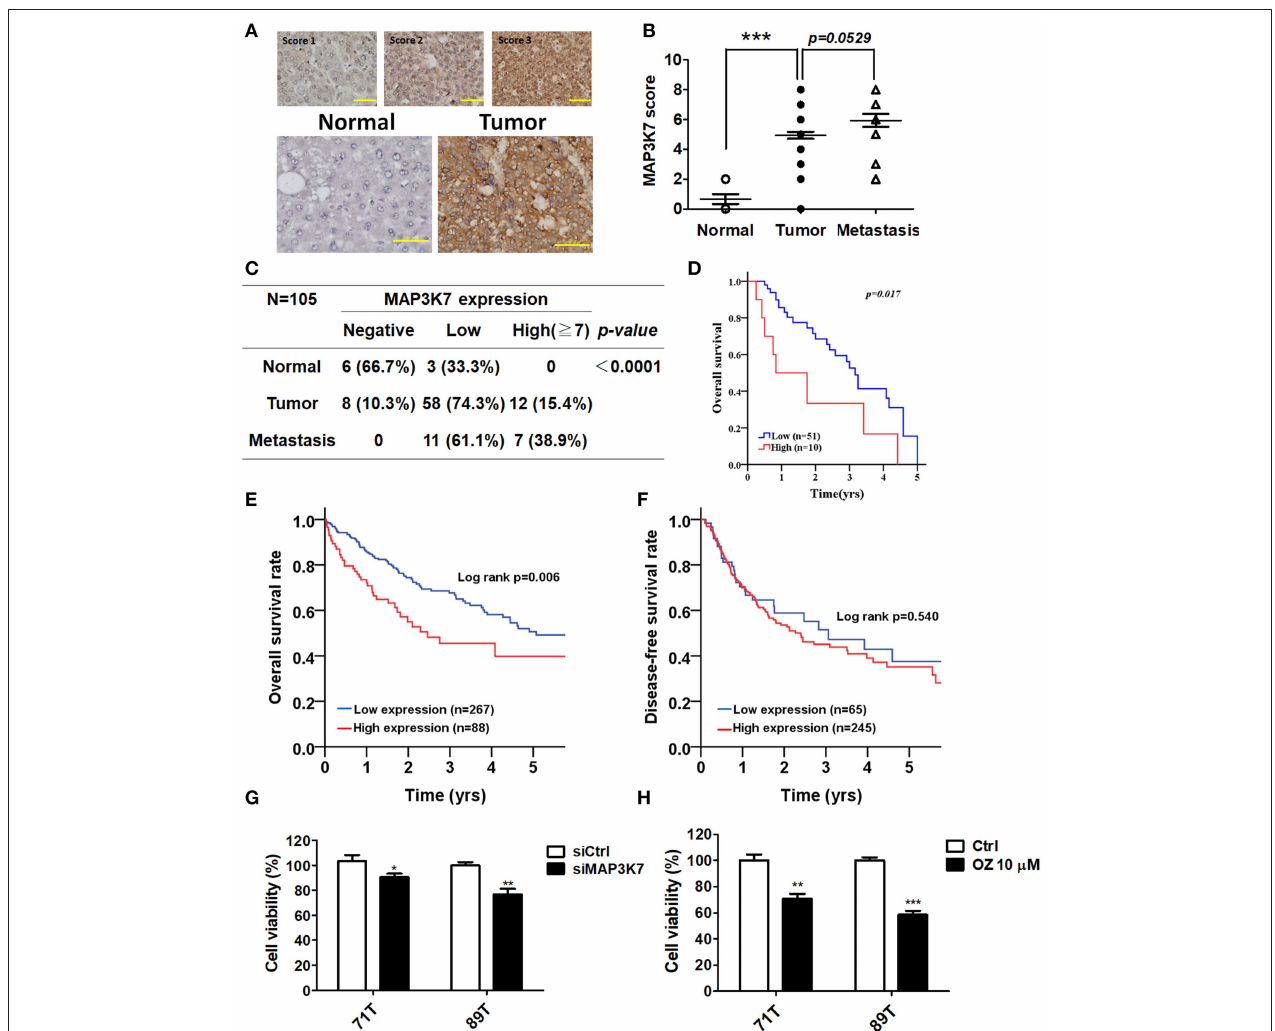
FIGURE 5 | Clinical association of MAP3K7 expression with tumorigenesis and malignancy in patients with HCC. (A) MAP3K7 protein level in HCC tumor tissues was determined by immunohistochemistry, and the intensity score was categorized into three grades according to MAP3K7 expression (upper panel). Representative staining for MAP3K7 in adjacent normal tissues and tumor tissues is shown (upper panel). Scale bar: 100 µ m. (B) The Allred score system was used to evaluate MAP3K7 protein levels in each tissue based on the sum of an intensity score and a proportion score ranging from 2 to 8. The quantitative results for MAP3K7 protein level in adjacent normal, tumor, and metastatic tumor tissues are shown. (C) MAP3K7 protein levels < 5 and ≥ 5 were considered low and high expression, respectively. A protein level of 0 was defined as negative expression. P -values were estimated by the Wilcoxon-signed rank test. (D) Kaplan-Meier plots were used to analyze the association of MAP3K7 expression with overall survival. (E) The correlation of MAP3K7 gene expression with overall survival or (F) disease-free survival was analyzed according to an HCC dataset from TCGA. (G) The MAP3K7 gene was silenced in primary HCC cells by siRNA for 72h, and the effects of silencing on cytotoxicity were determined with Cell-Titer Glo. (H) Primary HCC cells were treated with the MAP3K7 kinase inhibitor (5Z)-7-oxozeaenol for 24h, and its cytotoxic effects were examined. * p < 0.05; ** p < 0.01; *** p <